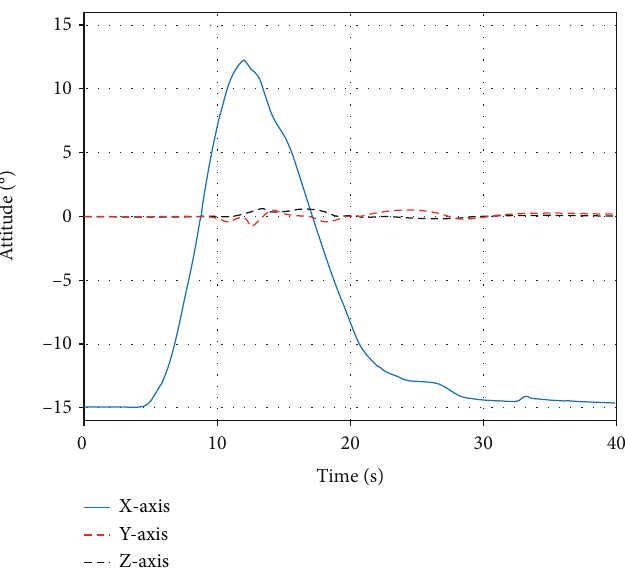
Figure 5: Attitude angle of payload module with PD controller.